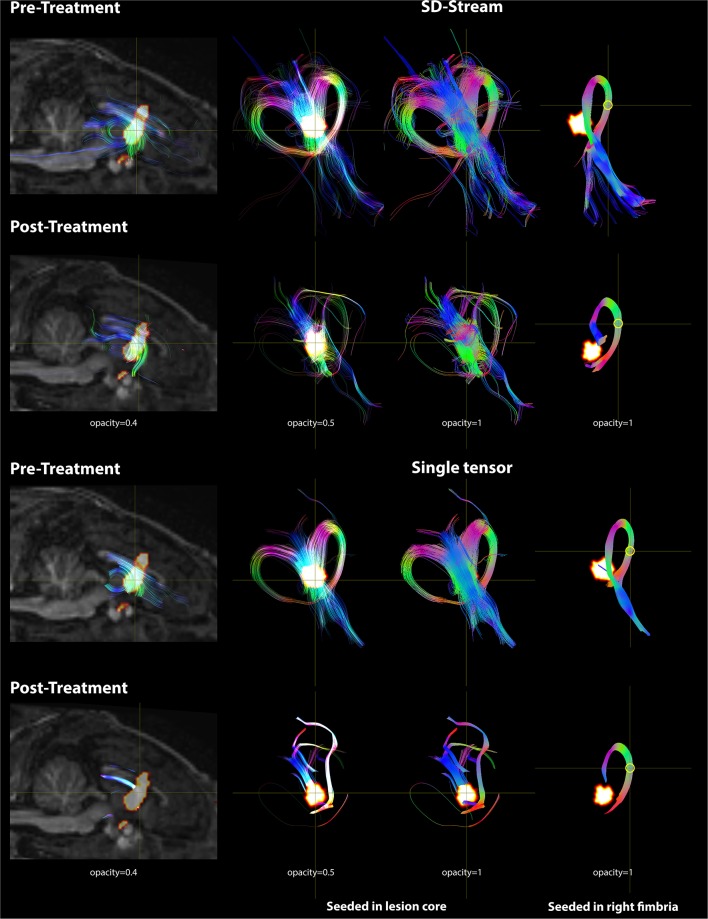
DWI tractography seeded in the lesion core and right fimbria is presented with both the FOD model using SD-Stream and the single tensor model. Left: mid-sagittal T1w image overlaid with the lesion core (seed region) and the tracts generated based on that seed (with opacity of 0.4). Middle: tracts seeded in the lesion core in 3D space with opacity of 0.5 and 1, respectively. Right: tracts seeded in the right fimbria (yellow circle) in 3D space. Tracts are colored by orientation (red, right–left; green, superior–inferior; blue, anterior–posterior).